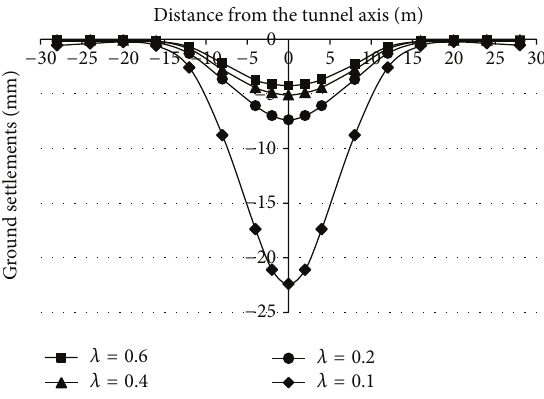
Figure 12: Relation curves between the supporting pressure and the horizontal ground settlements in the sand